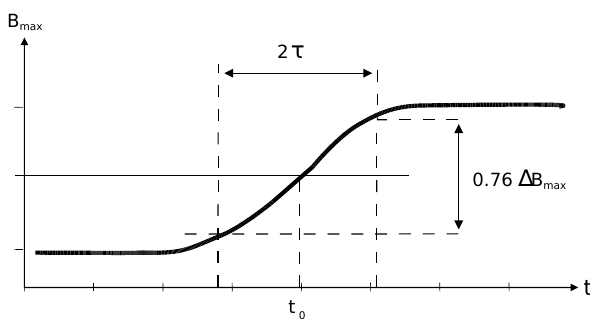
Fig. 2. Our definition of crossing time, t 0 , and crossing duration, 2 τ for a Harris sheet-like profile of B max . With a known magnetopause velocity, V MP , the magnetopause thickness, d MP is given by 2 τ ∗ V MP